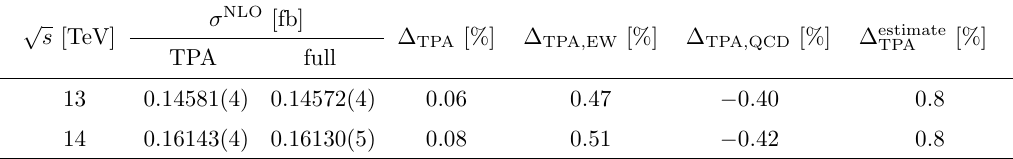
Table 6. Comparison of the NLO cross sections (cid:27) NLO of the process pp ! e (cid:0) (cid:22) (cid:23) e (cid:22) + (cid:23) (cid:22) (cid:28) + (cid:23) (cid:28) + X in the TPA with the full o(cid:11)-shell calculation and the relative di(cid:11)erences (cid:1) TPA for di(cid:11)erent CM p energies s . Monte Carlo integration errors are given in parentheses.